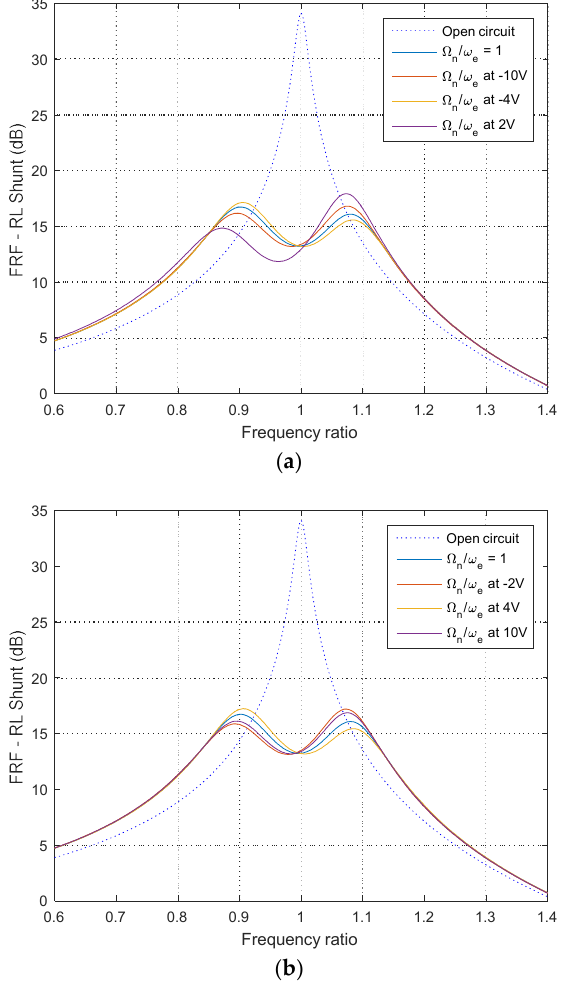
Figure 7. Simulations of the mistuning effect of the voltage controlled synthetic inductors (VCSI) nonlinearity in RL shunt vibration damping: ( a ) VCSI with an AD633 multiplier as a VCR and ( b ) VCSI with an LM13700 OTA as a VCR.